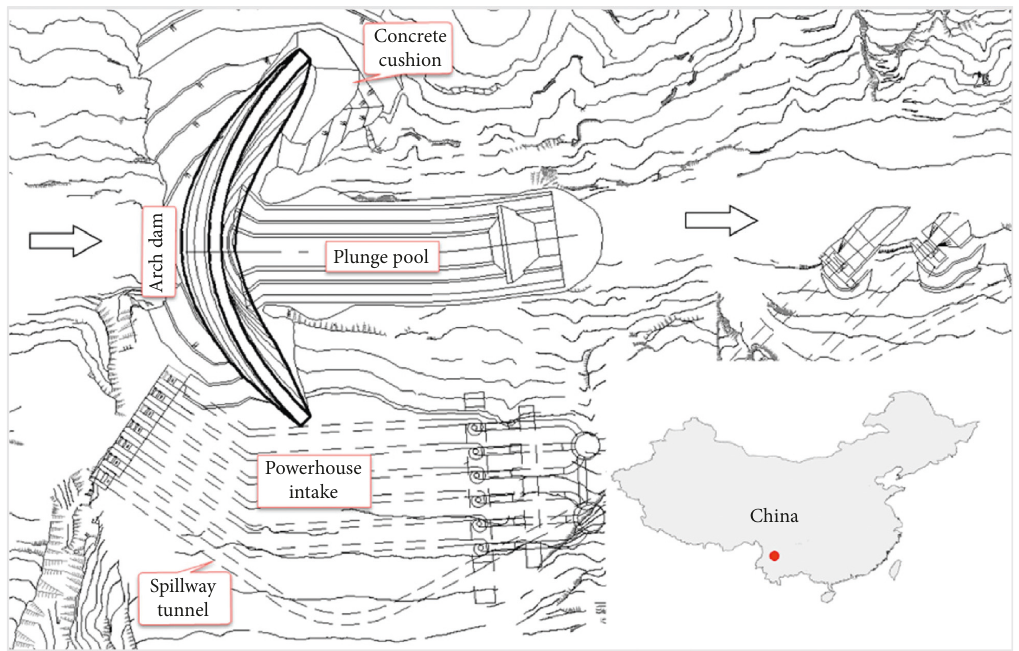
Figure 4: Layout chart of the Jinping-I high arch